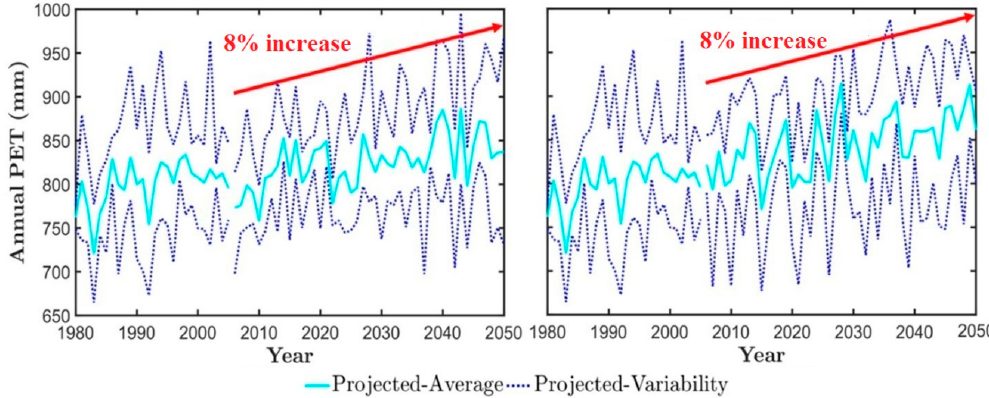
Figure 10. Time series of annual PET based on four GCM models for the historical period (1980–2005) and projected period (2006–2050) considering RCP 4.5 ( left ) and RCP 8.5 ( right ). The average curve is the average of four GCM models, and the variability curves are the minimum and maximum of four models. The red line is the slope of the time series during the projected period. The percent change from 2006 to 2050 is shown in red above each